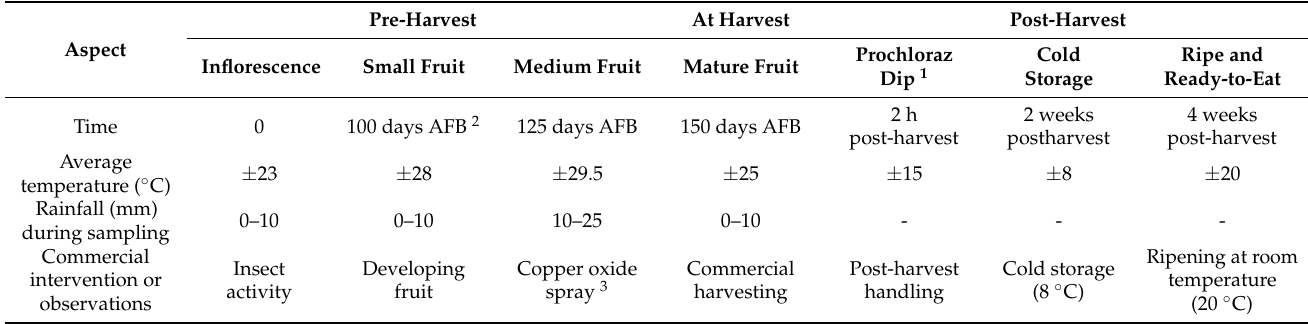
Table 1. Summary of sampling stages, weather data and physical and chemical interventions during the mango develop- mental and post-harvest